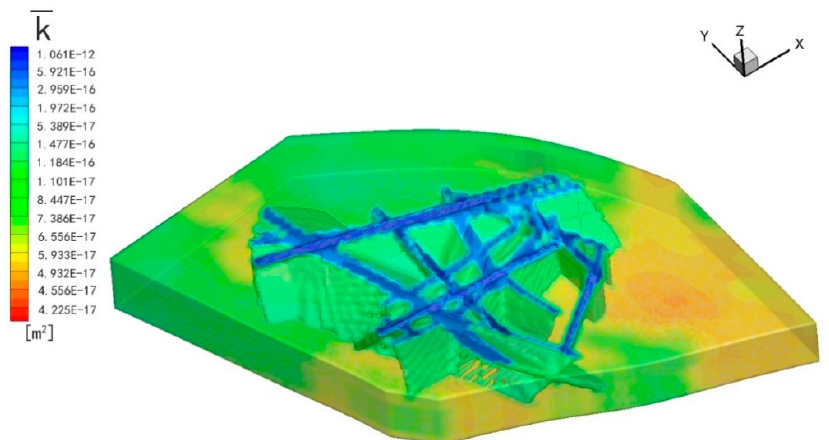
Figure 8. Contour plot of 𝑘(cid:3364) and isosurface of 𝑘(cid:3364) in fracture area.